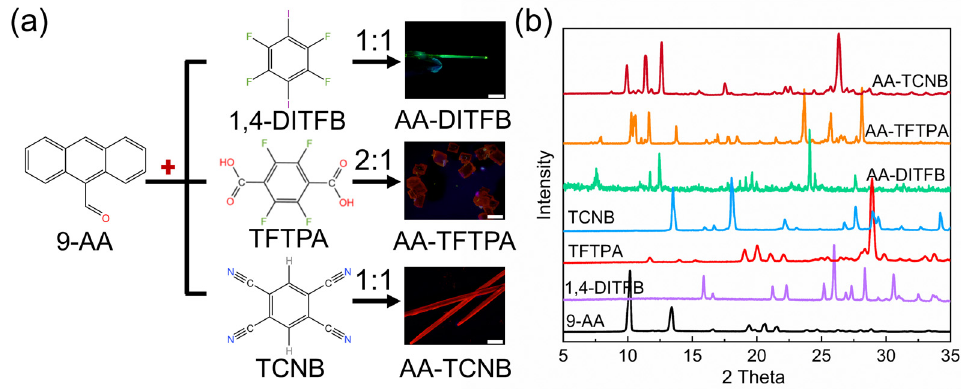
Figure 1. ( a ) Chemical structures of 9-AA and coformers and fluorescence images of cocrystals (under 365 nm UV-light, scale bar: 1 mm). ( b ) PXRD pa tt erns of 9-AA, coformers, and cocrystals.